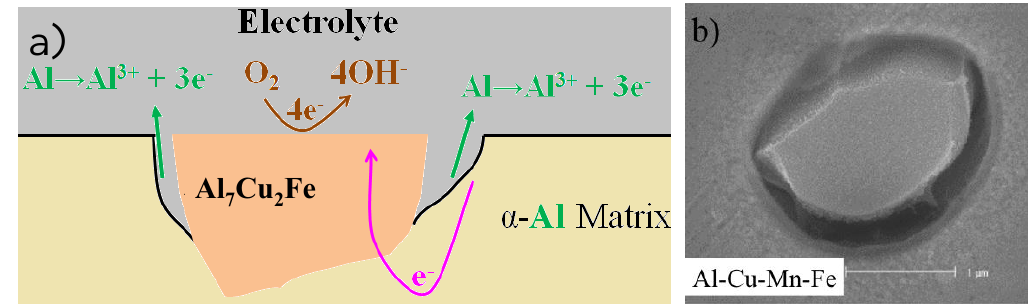
Figure 2. Schematic trenching corrosion process of Al 7 Cu 2 Fe in AA2024-T3 ( a ); and SEM image of the resulted corrosion morphology after 1-hour exposure in De-ionized water at 30 °C ( b ).